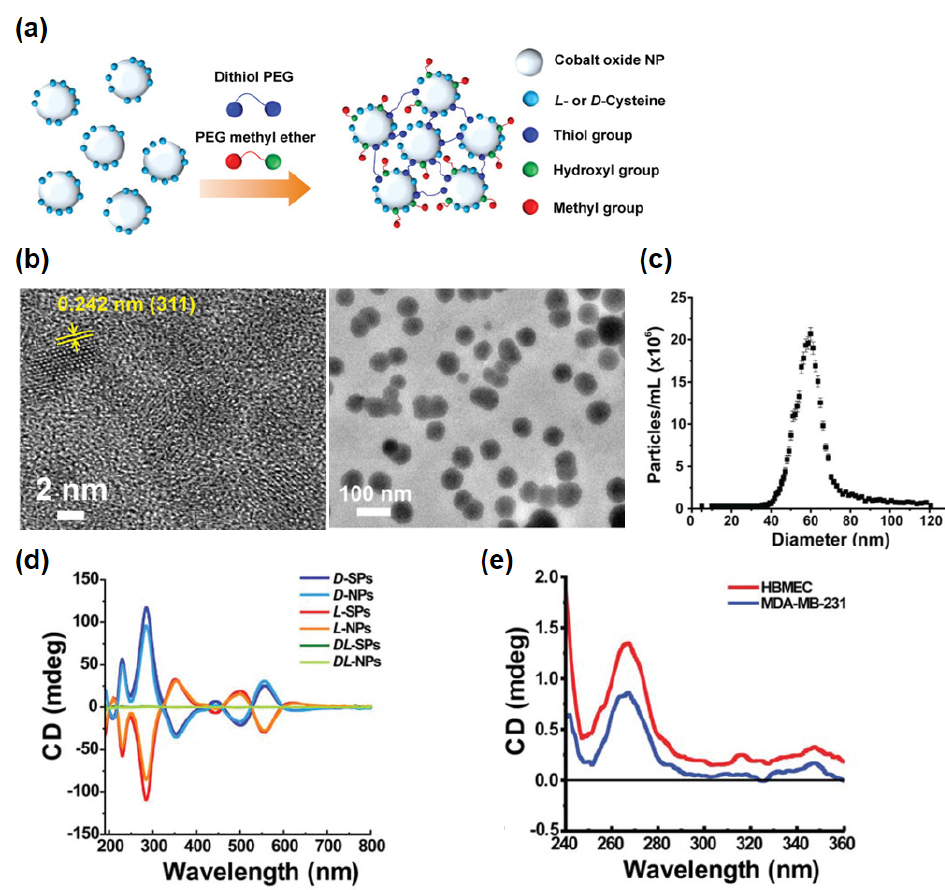
Figure 1. Characterization of chiral cobalt oxide NPs and SPs. ( a ) Schematic illustration of chiral NPs’ self-assembly into SPs. ( b ) Transmission electron microscopy (TEM) image of L -SPs and D -SPs. Yellow arrows indicate the (311) lattice fringe of chiral cobalt oxide NPs. ( c ) The size distribution curve of SPs. ( d ) CD spectra of SPs and NPs with different chirality. ( e ) CD spectra of lipids extracted from human cell (HBMEC and MDA-MB-231). Reprinted with permission from Ref. [19]. Copyright 2019 John Wiley and Sons.